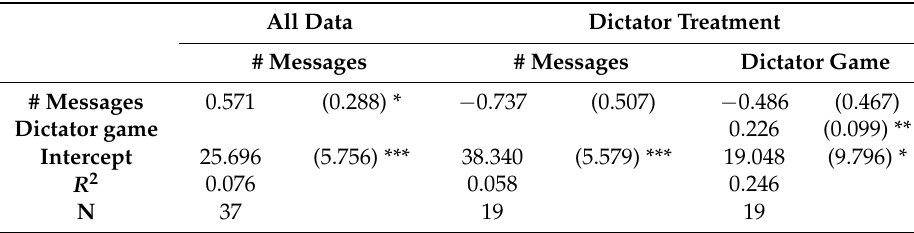
Table 4. Factors influencing decisions in bargaining